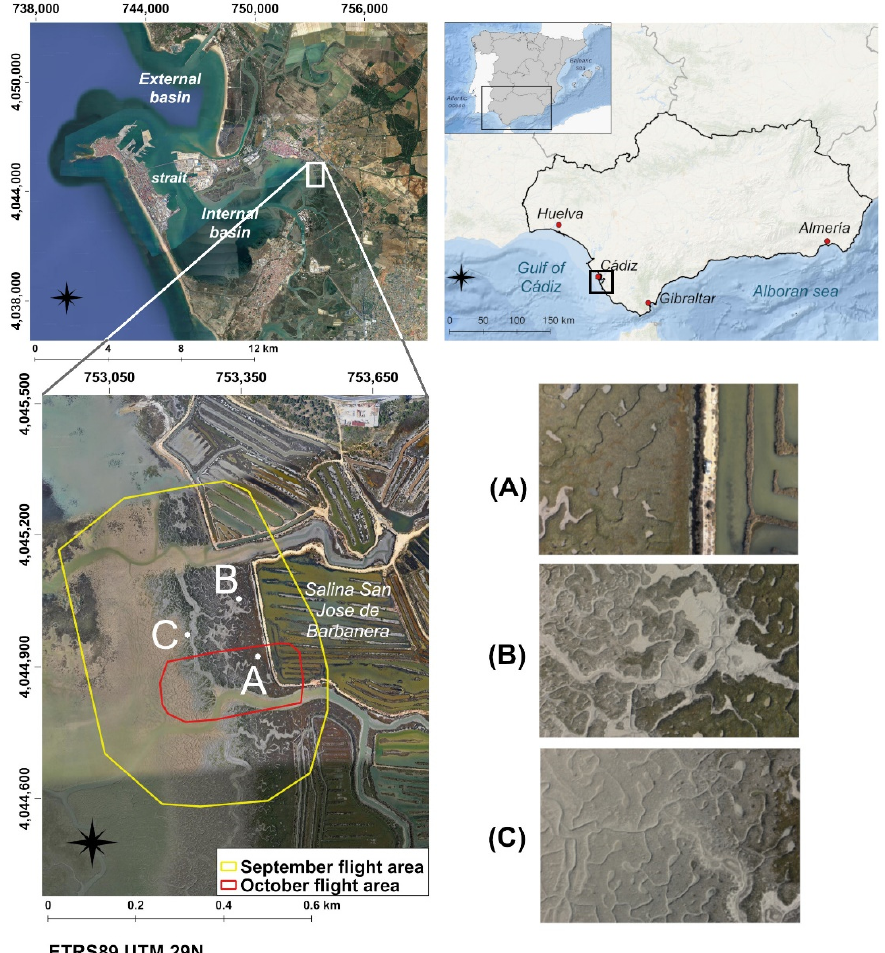
Figure 1. Location of Cádiz Bay and detailed view of the study site in the internal basin (in front of the salina San José de Barbanera). The yellow polygon indicates the flight area in September 2021 and the red one is for the flight area in October 2021. ( A – C ) are drone-captured images at the corresponding points in the left image: the uppermost part of the salt marsh system and a portion of a salina with its external wall on the right ( A ), a zone with a transition of dominant vegetation between Sarcocornia spp. and S. maritimus ( B ), and the lowermost part of the salt marsh system with a clear view of the tidal channel network ( C ).